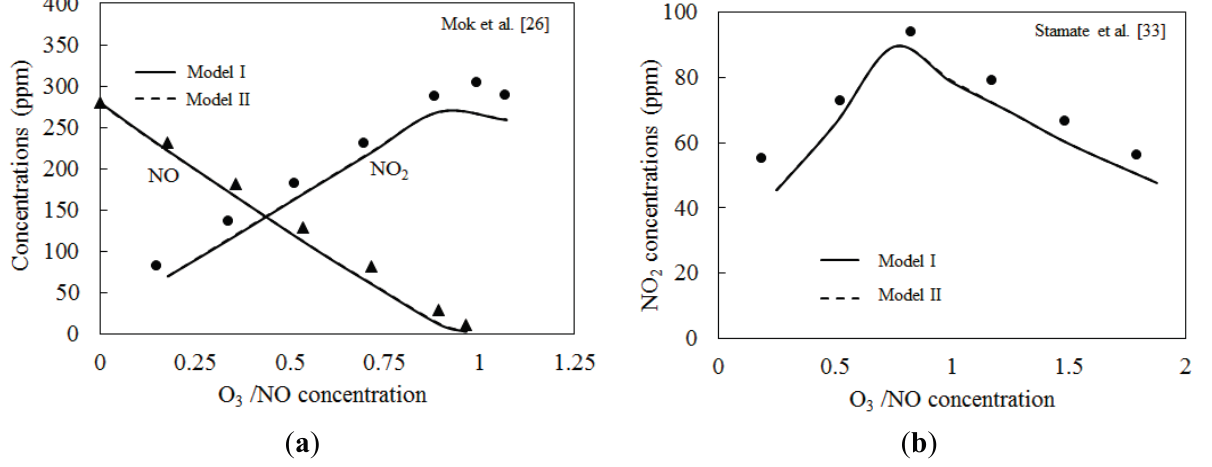
Figure 3. Comparison of predicted results with experimental data. ( a ) Initial NO: 280 ppm, NO 2 : 20 ppm, 25 °C; ( b ) Initial NO: 80 ppm, 40